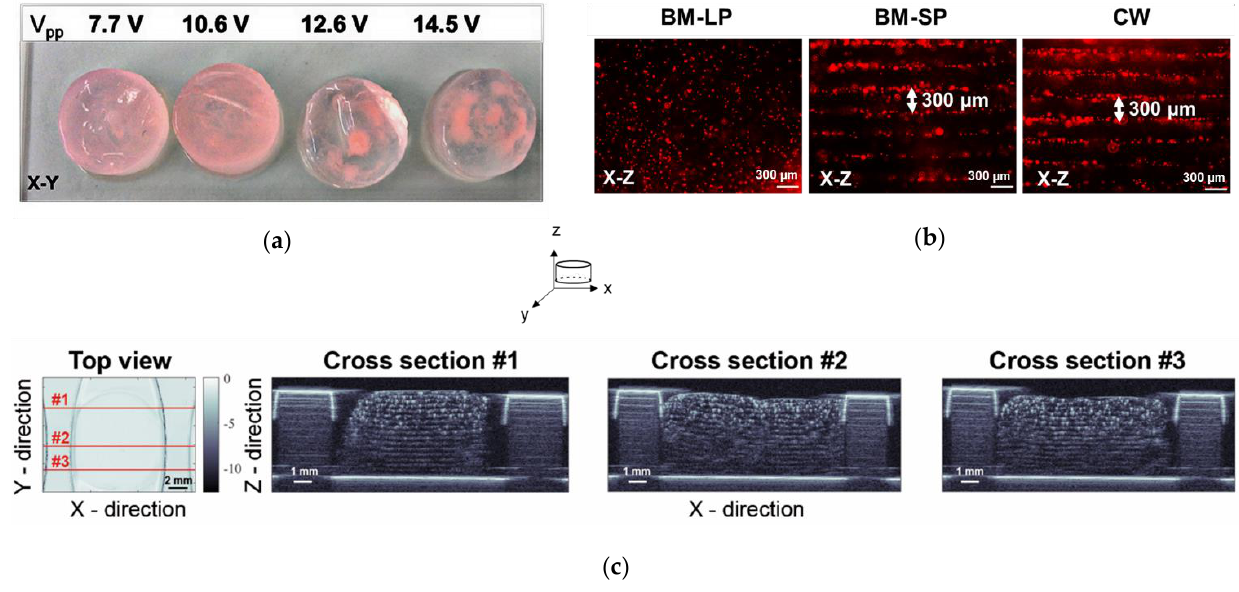
Figure 1. ( a ) Photographs of hydrogels from the top (X-Y) at increasing transmission peak-to-peak voltage (Vpp); ( b ) fluorescence images of red beads (12 µm) patterned at different ultrasound wave modes, where BM-LP, BM-SP and CW stand for ultrasound burst mode short pulses, burst mode long pulses and continuous wave, respectively; ( c ) SAM200Ex C-scan mode acoustic microscopy images of patterned fibrin gels at three different X-Z projections. The representative images are of the experiments repeated three